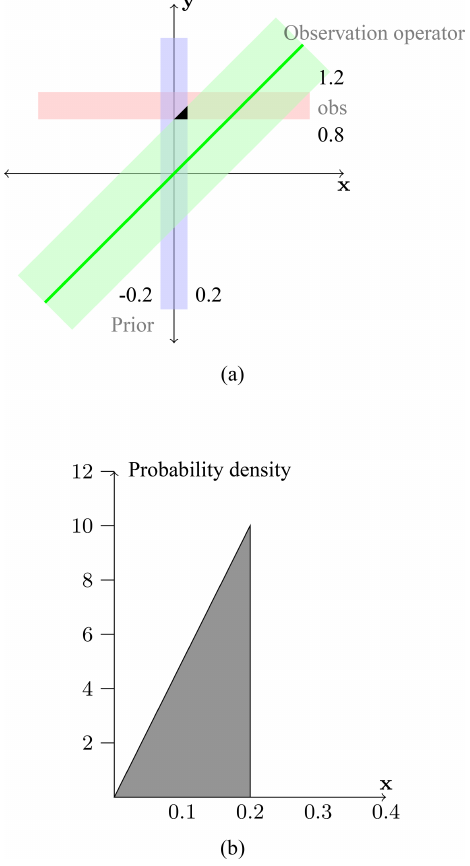
Figure 1. Illustration of Bayesian inference for a system with one target variable and one observation. Panel (a) shows the joint prob- ability distribution for target variable ( x axis) and measurement ( y axis). The light-blue rectangle (which extends to infinity in the y direction) represents the prior knowledge of the target variable (uni- formly distributed between − 0 . 2 and 0 . 2). The light-red rectangle (which extends to infinity in the x direction) represents the knowl- edge of the true value of the measurement (uniformly distributed between 0 . 8 and 1 . 2). The green rectangle (extending to infinity along the one-to-one line) represents the state of knowledge of the observation operator. The observation operator is a simple one-to- one mapping represented by the heavy green line. The black trian- gle (the intersection of the three PDFs) represents the solution as the joint PDF. Panel (b) shows the PDF for target variables obtained by projecting the black triangle from (a) onto the x axis (i.e. integrat- ing over all values of the observation). Figure modified from Rayner